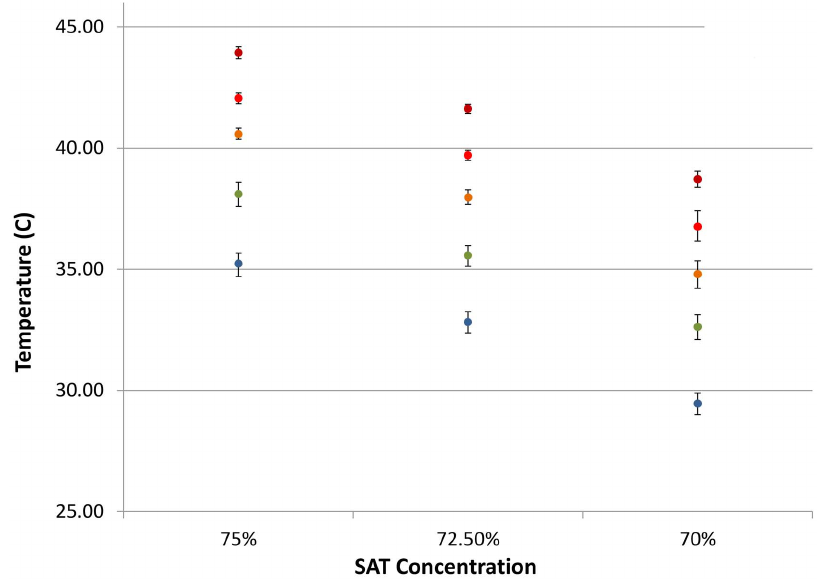
Figure 2. Median peak temperatures produced by different concentrations of SAT when held and activated under a variety of ambient temperatures. Ambient temperatures of SAT mixtures during activation: blue 10 u C; green 15 u C; orange 20 u C; turquoise 25 u C and red 30 u C; SAT, Sodium acetate trihydrate.